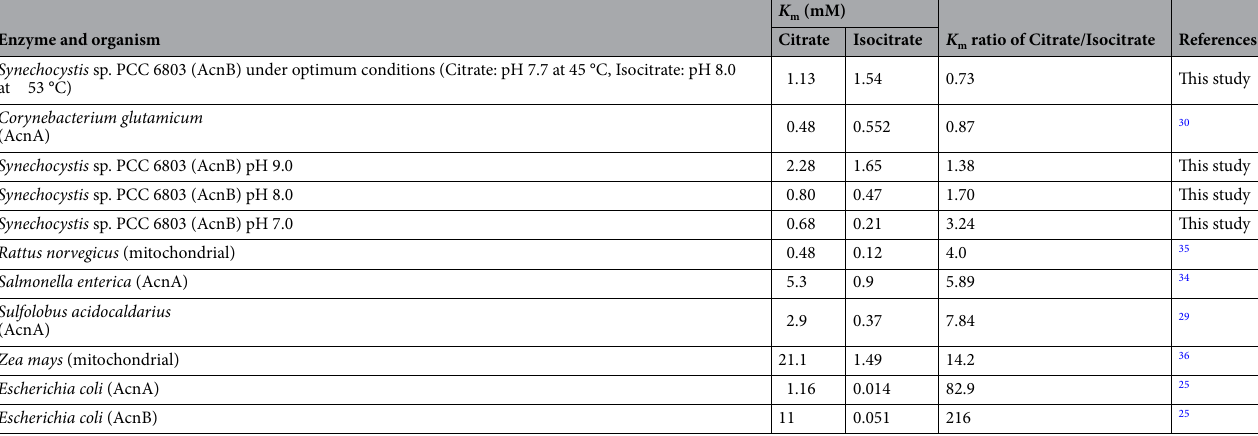
Table 3. List of K m values with aconitase from various organisms. In E. coli , two different K m values for isocitrate were obtained with different substrates at varying concentration ranges and compared with those measured for isocitrate (0.01–40 mM). The P -values between citrate and isocitrate calculated by Student’s t -test were listed in Table